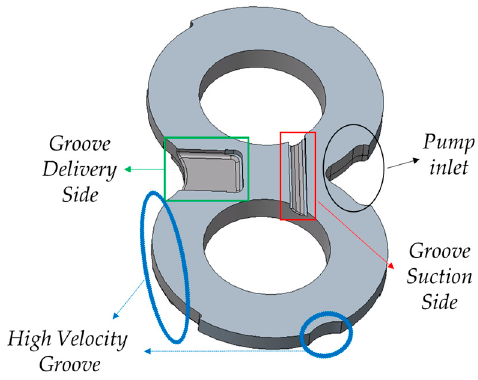
Figure 2. Grooves inside the lateral plates.